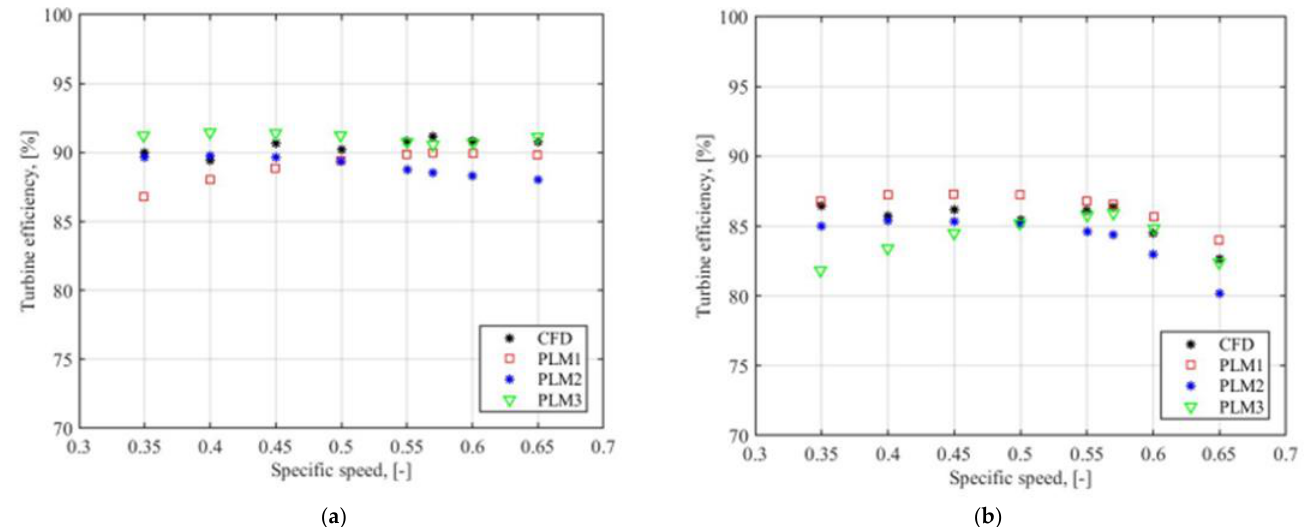
Figure 7. Turbine efficiency: ( a ) without the exit kinetic loss and ( b ) with exit kinetic loss.